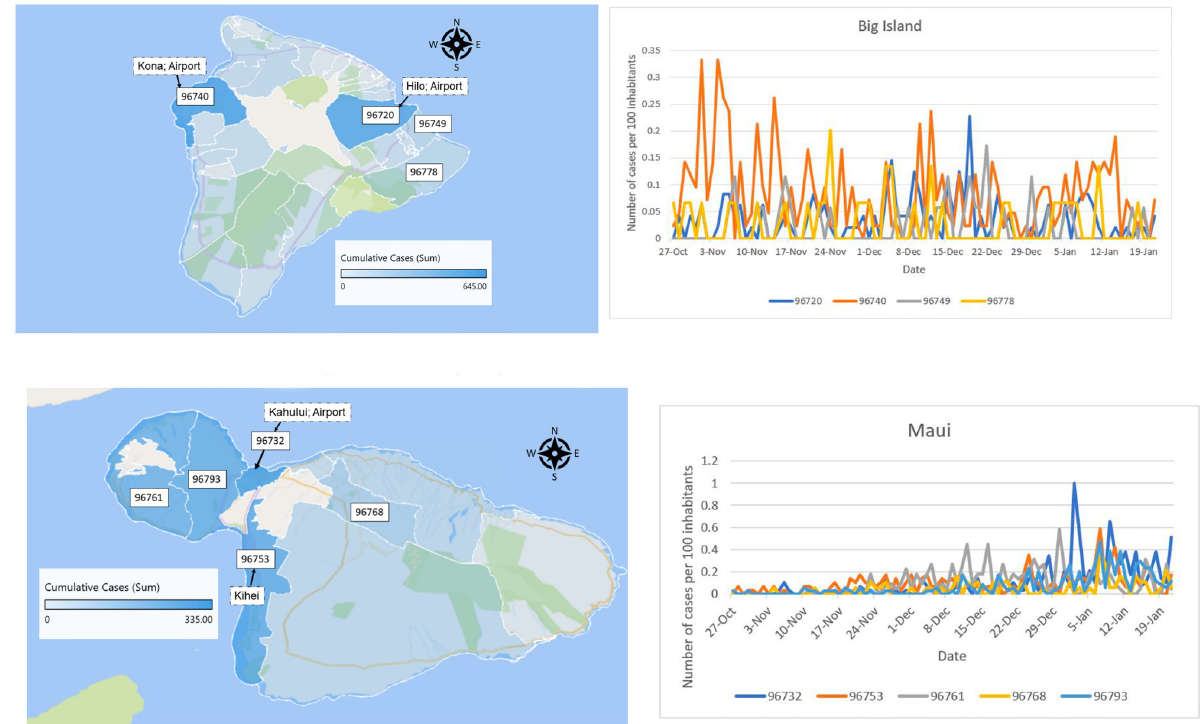
Fig 9. Hawai‘i and Maui cumulative daily counts distributed per zip code from October 2020 to January 18, 2021. A. Hawaii County. Cases restricted to the two major towns Hilo and Kona. B. Maui county. There were a few clusters on Maui which is an explanation for some of the higher spikes, in particular in early January in Kahului which is zip code